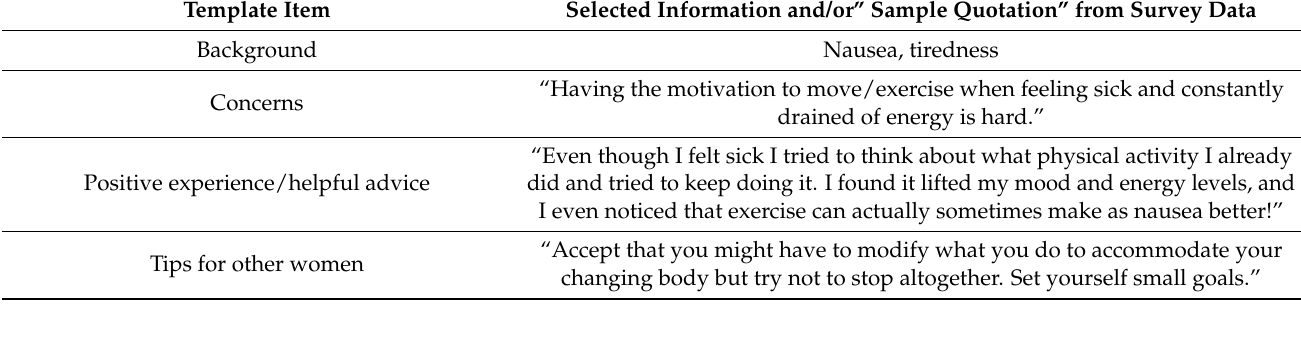
Table 2. Example ‘like me’ story template relating to nausea and fatigue.